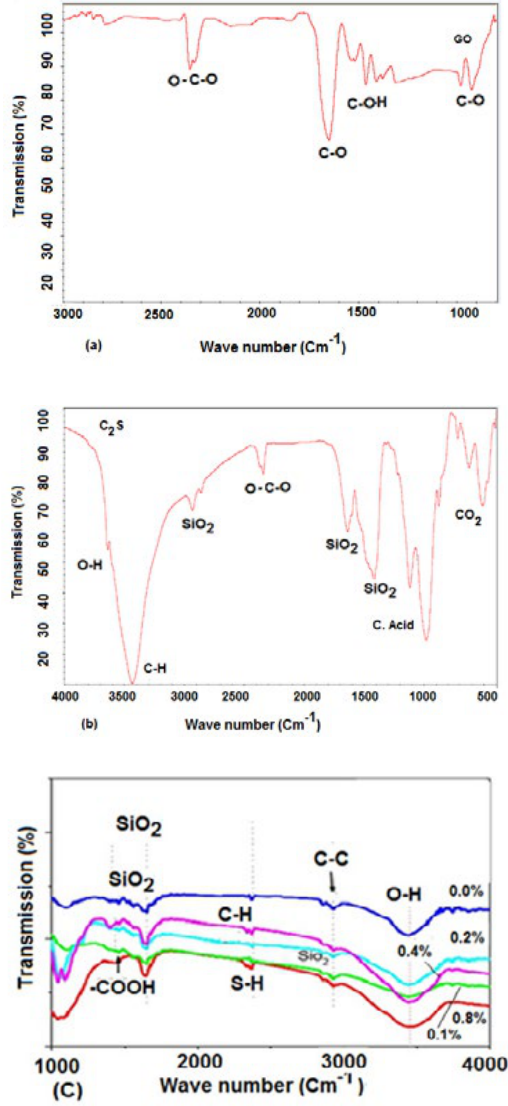
Fig. 1. (a) FT-IR pattern of GO, (b) FT-IR pattern of dicalcium silicate and (c) C S/ GO with 0.1, 0.2, 0.4 and 0.8 in wt.% 2 Figure 1. (a) FT-IR pattern of GO, (b) FT-IR pattern of dicalcium silicate and (c) C 2 S/ GO with 0.1, 0.2, 0.4 and 0.8 in wt.% GO.